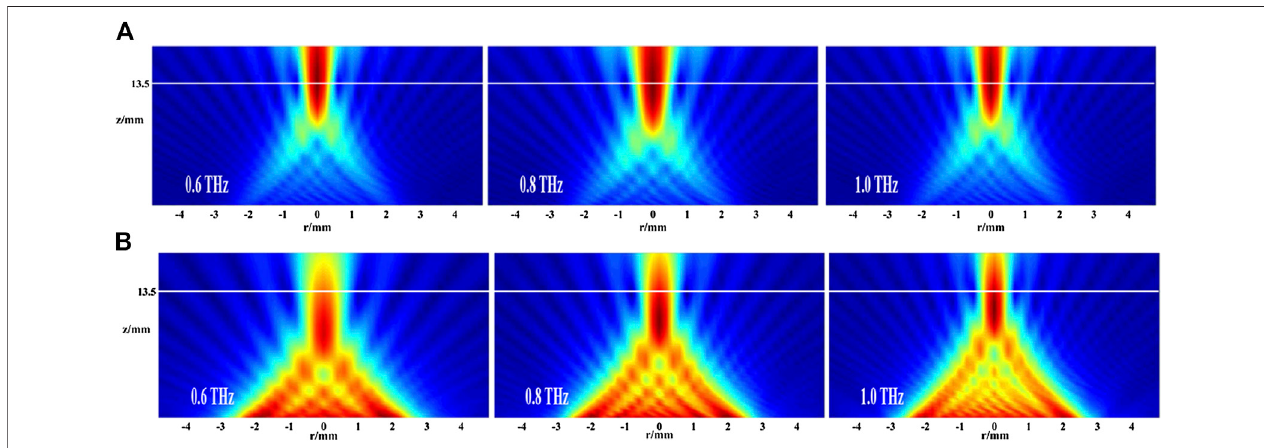
FIGURE7|(A) Thecalculatedidealfocusingperformanceoftheachromaticmeta-lenswiththe f / r amplitudedistributionat0.6,0.8,and1.0 THz,respectively.The white lines mark the designed focal length of 13.5 mm. (B) The focusing performance of the achromatic meta-lens without f / r amplitude distribution at 0.6, 0.8, and 1.0 THz,